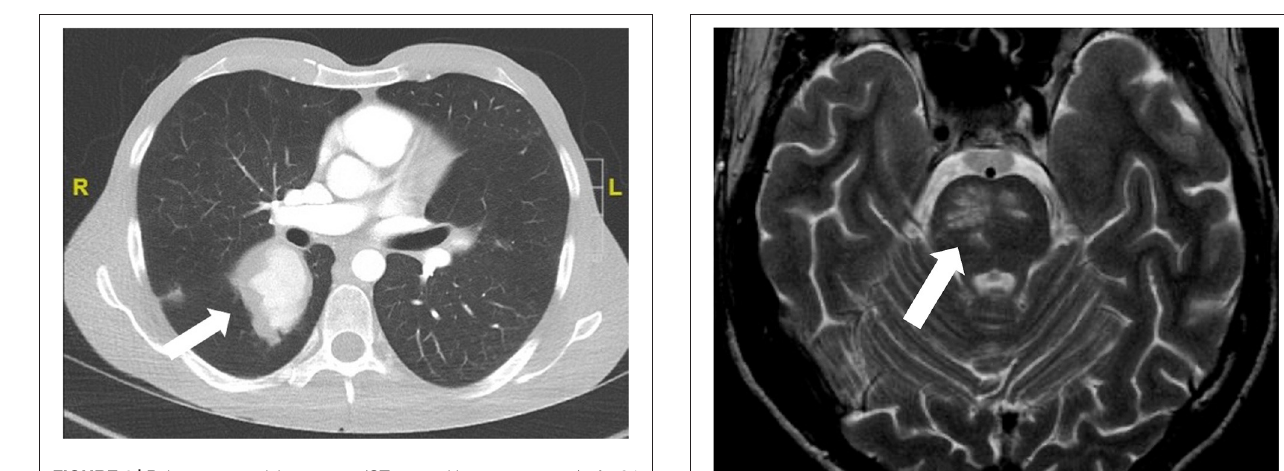
In 50% of the parenchymal CNS manifestations the brain stem is affected, where inflammatory lesions can be found on MRI ( Figure 2 ). Characteristic is a lesion in the midbrain or pons (30, 31). The clinical symptoms of these patients are